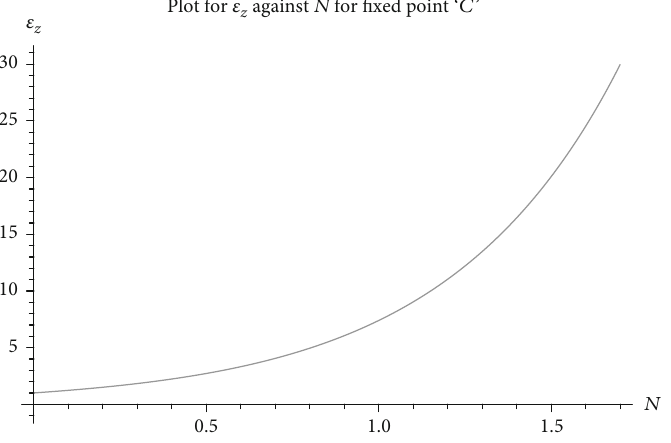
Figure 16: Shows the perturbations along the z -axis against N for fi xed point C